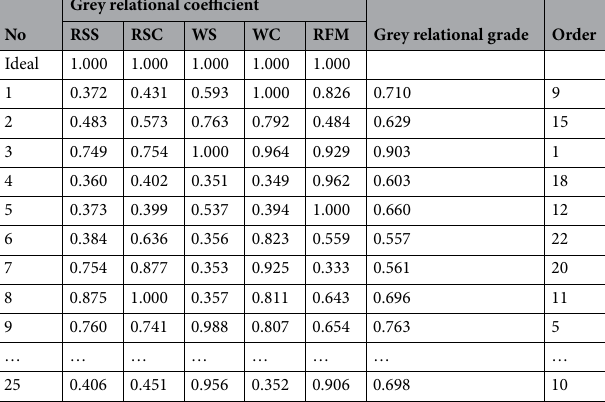
Table 10. The results of grey relational coefficient and grey relational